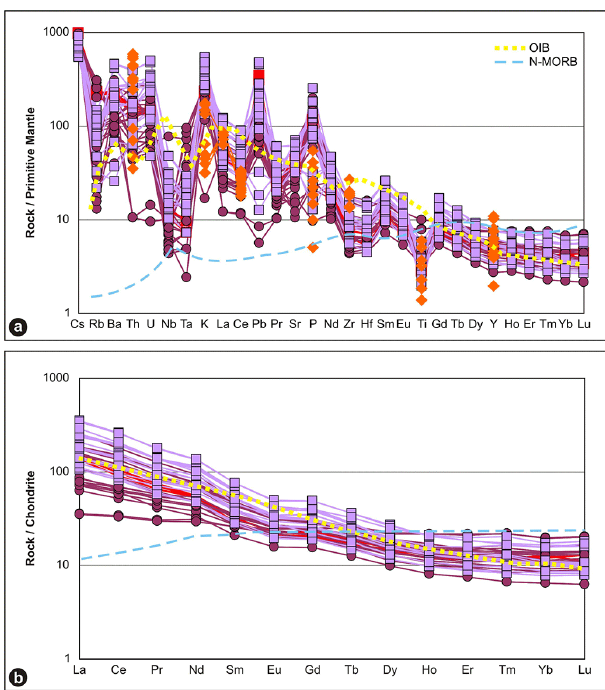
Fig. 17. (a) Primitive mantle-normalized multielement diagrams for the high-K shoshonitic arc rocks (normalization values from Sun and McDonough, 1989). (b) Chondrite-normalized REE patterns of the same rocks (normalization values from Sun and McDonough,